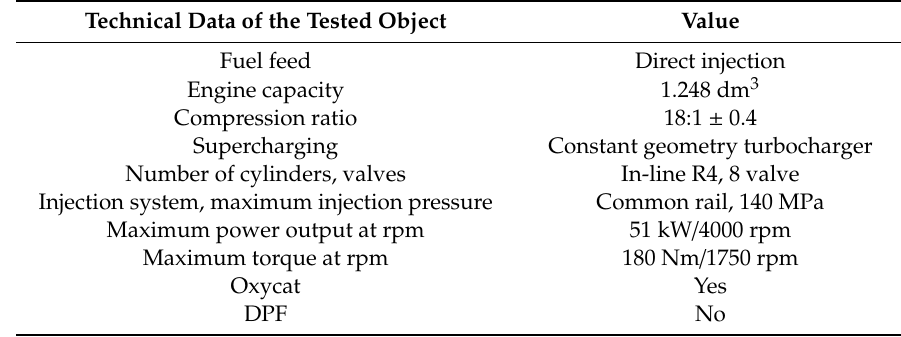
Table 1. Technical data of the tested object.